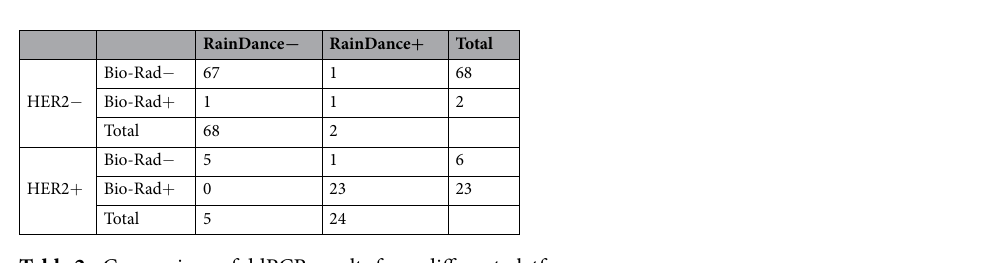
Table 2. Comparison of ddPCR results from different